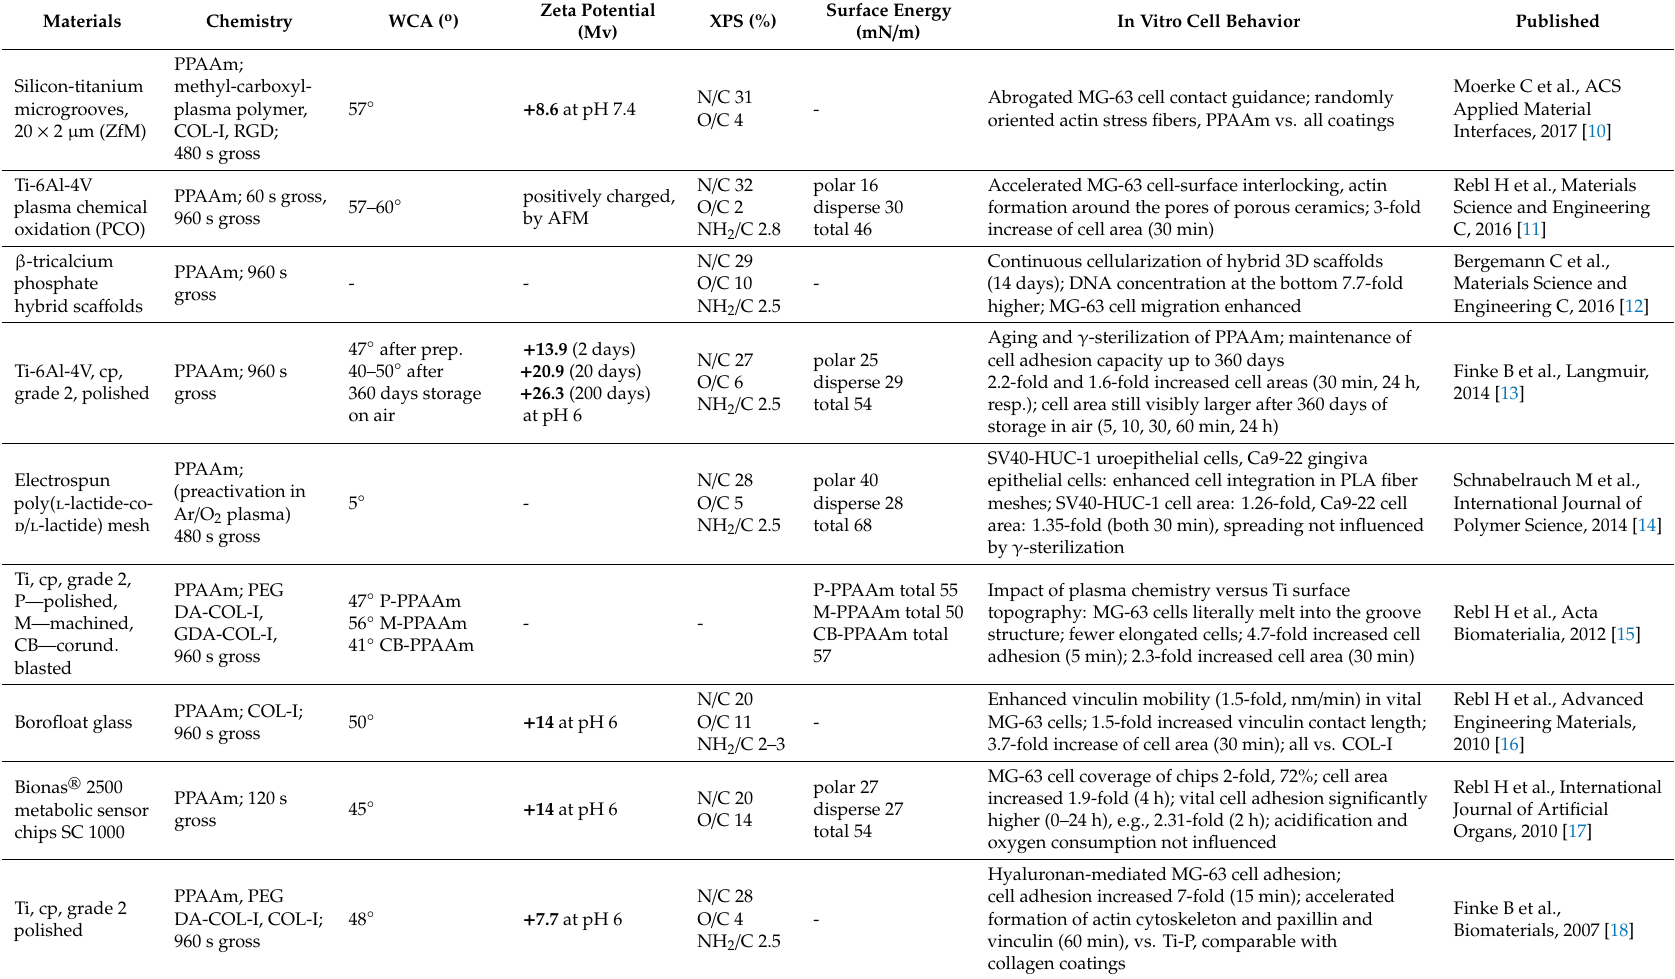
Table 1. Overview of plasma polymerized allylamine (PPAAm) surface coating of diverse bulk materials, their physico-chemical characteristics, and cell biological outcomes